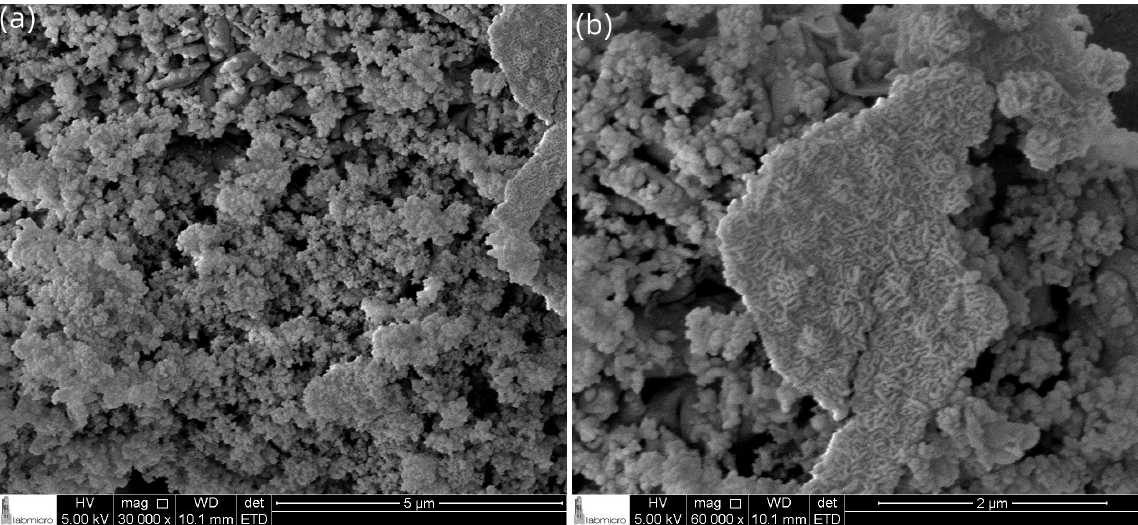
Figure 4. SEM photomicrographs of synthesized HAS clay ( a ) 30,000 × and ( b ) 60,000 × .